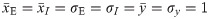
Learning temporally structured signals.A: Minimal loss ϵ, error ϵerr and norm of the weight vector w as a function of the load α for a linear perceptron trained on a time-correlated signal. Covariance matrix C is of rbf type with τ = 2. Parameters: N = 1000, fE = 0.8, γ = 0.1, x¯E=x¯I=σE=σI=y¯=σy=1. B: Optimal bias b for the two sets of signals with rbf (black curve) and exponential (yellow curve) covariance C, with τ = 2. Theoretical curves show the value IN+y¯, where I has been computed from the saddle-point equations (Methods: EC, Saddle-point equations). Parameters as in A. Each point in A and B is an average across 50 samples. C: Probability density of non-zero synaptic weights wiN of a linear perceptron with N = 1000, a fraction fE = 0.8 of excitatory weights, trained on P = 600 exponentially correlated input x and output y. The δ function in zero is omitted for better visualization. Parameters: τ = 10, γ = 0.1, x¯E=x¯I=1, σI = 2σE = 0.4. The histogram is an average across 50 realizations of input/output signals. Inset: full histogram of synaptic weights wiN.